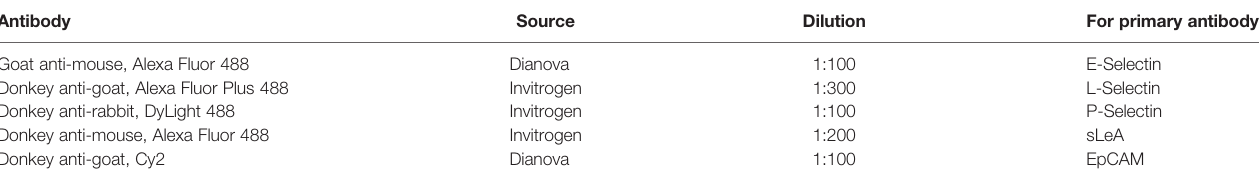
TABLE 3 | Details of fl uorescent secondary antibodies used in this study. Antibody Goat anti-mouse, Alexa Fluor 488